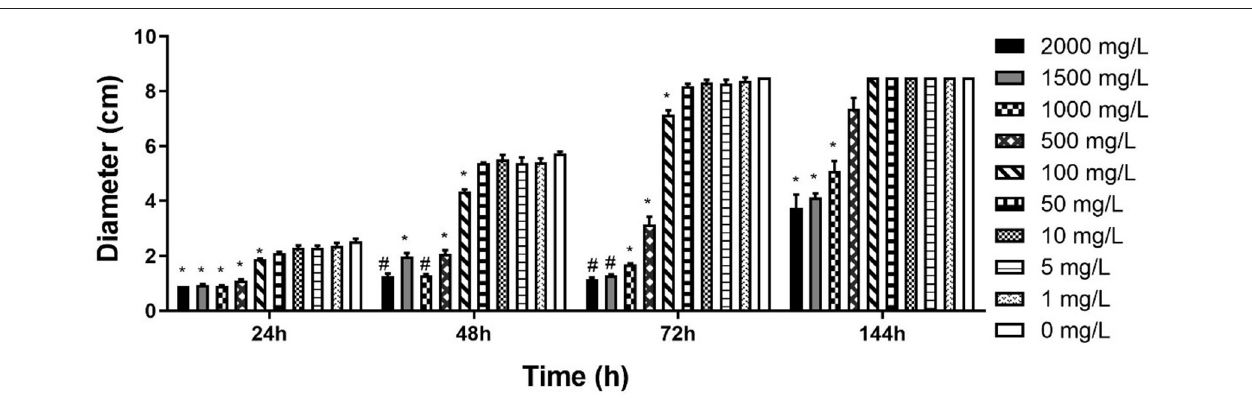
FIGURE 2 | The diameter of S. parasitica at different timepoints after treating with different concentrations CCCSNs. *: 0.001 < p < 0.05, #: p < 0.001. Error bars are ± SD, n = 3.